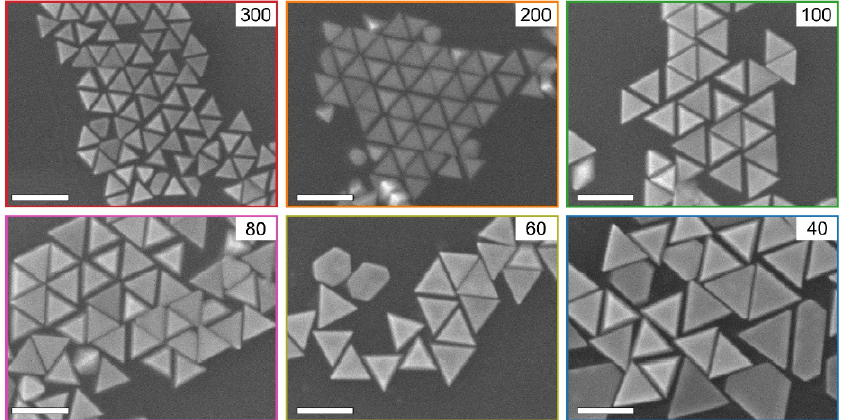
Figure 8. SEM images of purified gold nanotriangles synthesized after the time-optimized procedure. Labels indicate the volume ( µ L) of intermediate seeds used for each sample. Scale bars are 100